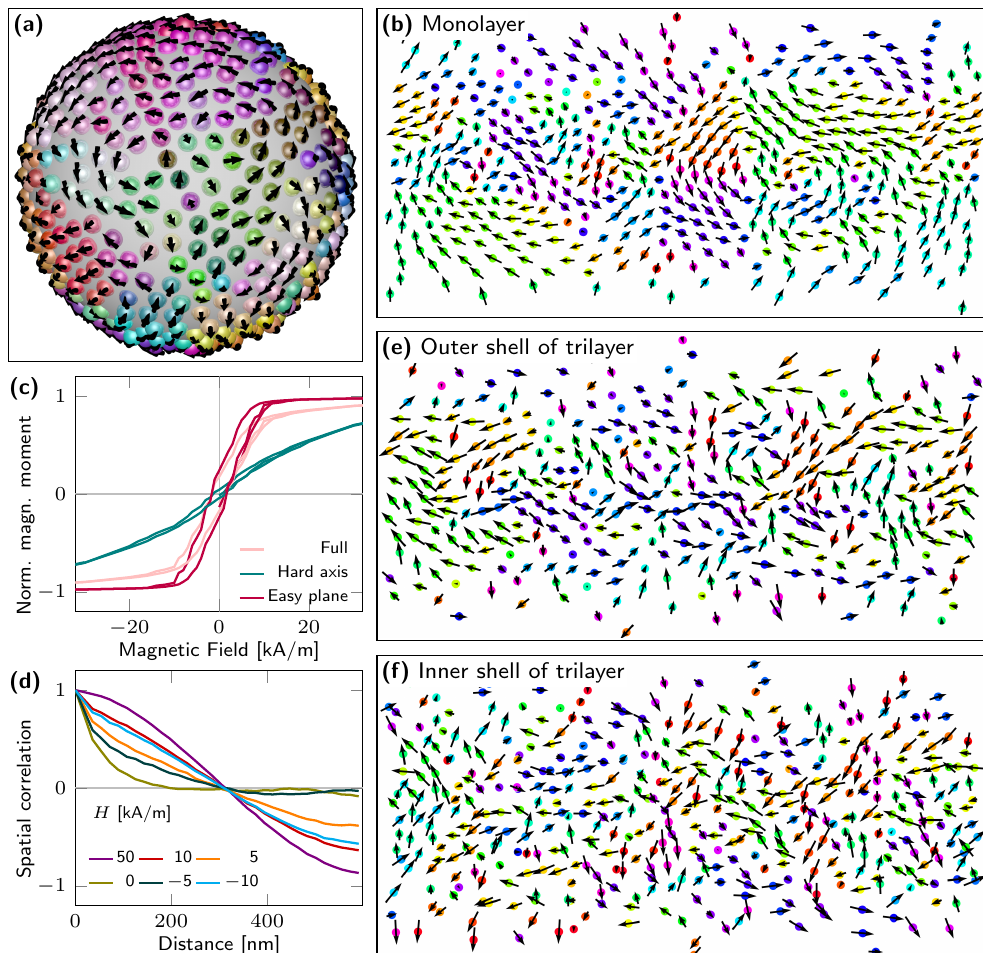
Figure 4. Magnetization configuration of XY macro-spins jammed on a curved 2D spherical shell. ( a ) 3D view of remanent state of monolayer nanoparticle surfactants (Fe 3 O 4 : ∅ = 25 nm, M s = 300 kA/m, T = 0 K) stochastically positioned on sphere with mean distance of 30 nm (Fe 3 O 4 plus ligand shell). Black arrows indicate direction and magnitude of tangential magnetization components. Color refers to polar angle of magnetization vector. ( b ) 2D view ( φ vs. θ ) of remanent magnetization projected onto curved surface revealing magnetization reversal via vortex nucleation. Color highlights in-plane magnetization direction. ( c ) Magnetic hysteresis loops for entire magnetic system, and easy plane and hard axis regions. The in-surface anisotropy originates from magnetic dipole coupling between adjacent nanoparticles that manifests a remanent magnetic moment. ( d ) Spatial spin-spin correlation calculated for 2D system, i.e., not in 3D space, at various magnetic fields revealing magnetic short-range order at remanence (vortices and domains) and long-range order in the presence of external magnetic fields. ( e , f ) 2D views ( φ vs. θ ) of remanent magnetization for trilayer nanoparticle surfactants demonstrating substantially weaker dipole coupling perpendicular to the interface and reduced in-surface anisotropy and magnetic